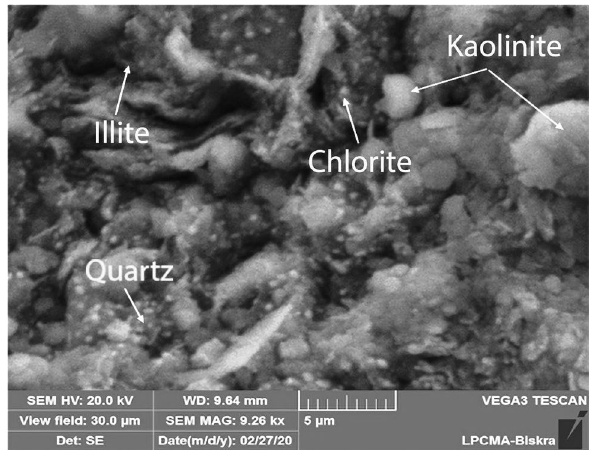
Fig. 9 SEM photomicrographs (backscatter images) of sample T1